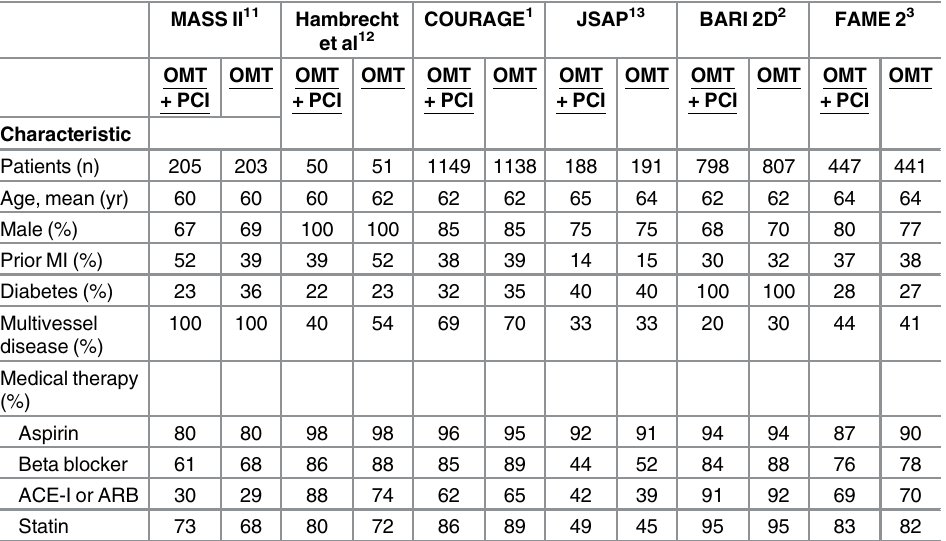
Table 2. Characteristics of patients.